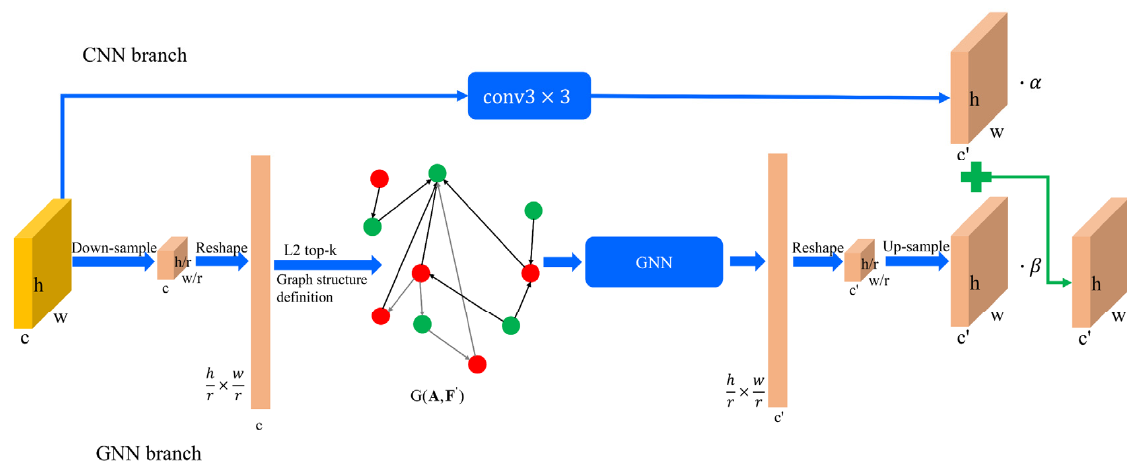
Figure 3. General structure of CGBlock.